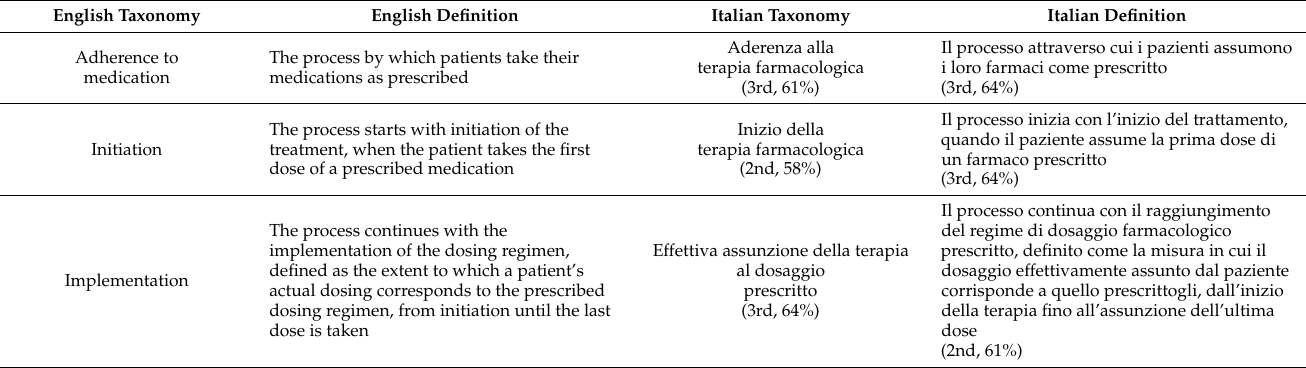
Table 3. Italian translation of the ABC taxonomy and corresponding definitions including the acceptance rate (%) after the corresponding Delphi round (2nd,